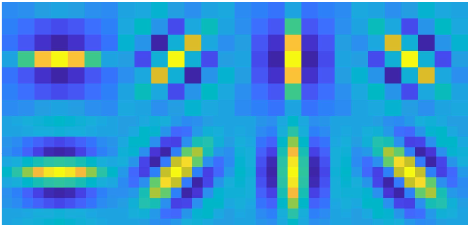
Figure 2. A graphical representation of the Gabor filter bank. Filter with scale in 7 × 7 and 11 × 11 from top to bottom, the angle from left to right are 0, 45, 90, and 135 degrees, gamma is set to 1 so the filter is round, psi is 0 so no phase shift. Warm colors indicate larger values and cool colors indicate smaller values.